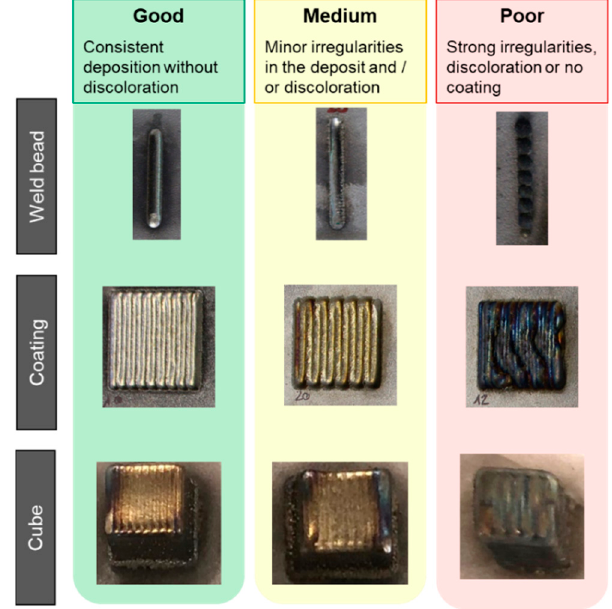
Figure 3. Categorization of the different geometries .